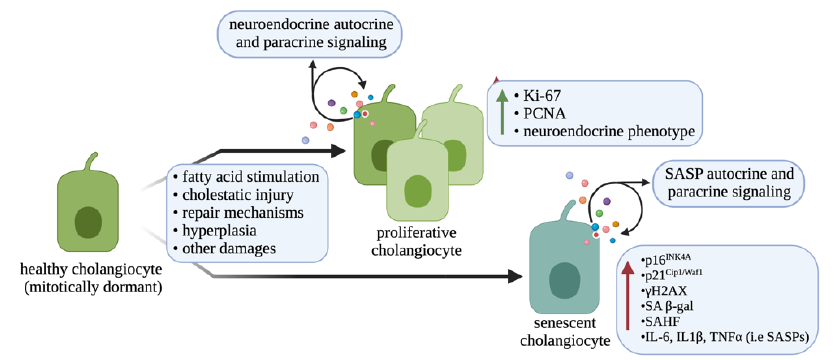
Figure 1. Molecular differences between healthy, proliferative and senescent cholangiocyte. After exposure to various damaging effects, cholangiocytes can undergo changes in either their proliferative response or induction of senescence. Different cellular changes, such as enhanced expression of proliferative markers and correlation with the neuroendocrine phenotype are associated with proliferative cholangiocytes. Following induction of senescence, cholangiocytes can increase their expression of senescent factors, have senescence-associated heterochromatin foci (SAHF), and begin to secrete various senescence-associated secretory phenotype (SASP) factors. Other biliary damages (i.e., apoptosis, autophagy, and others) are not shown. Image made with BioRender (https://biorender.com/).